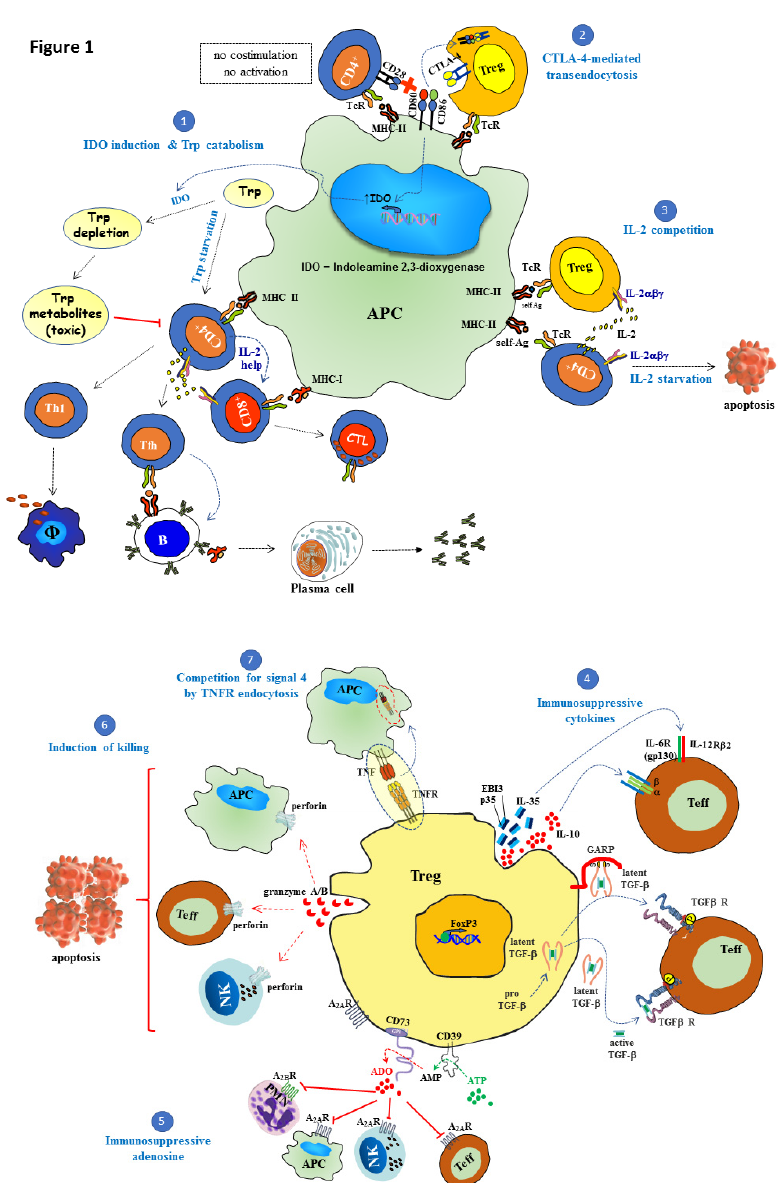
Figure 1. Suppressive mechanisms of regulatory T cells (Tregs). Regulatory T cells (Tregs) play a central role in maintaining immune self-tolerance and preventing autoimmune diseases. Tregs with suppressive function, characterized by expression of the forkhead / winged-helix transcription factor Foxp3 (Foxp3), are generated either in the thymus (tTregs) or in the periphery (pTregs), the latter from naïve T cells under the influence of TGF- β and IL-2. The following cell-extrinsic and cell-intrinsic Tregs suppressive mechanisms operate on effector T cells, NK cells, as well as on antigen-presenting cells (APC) to